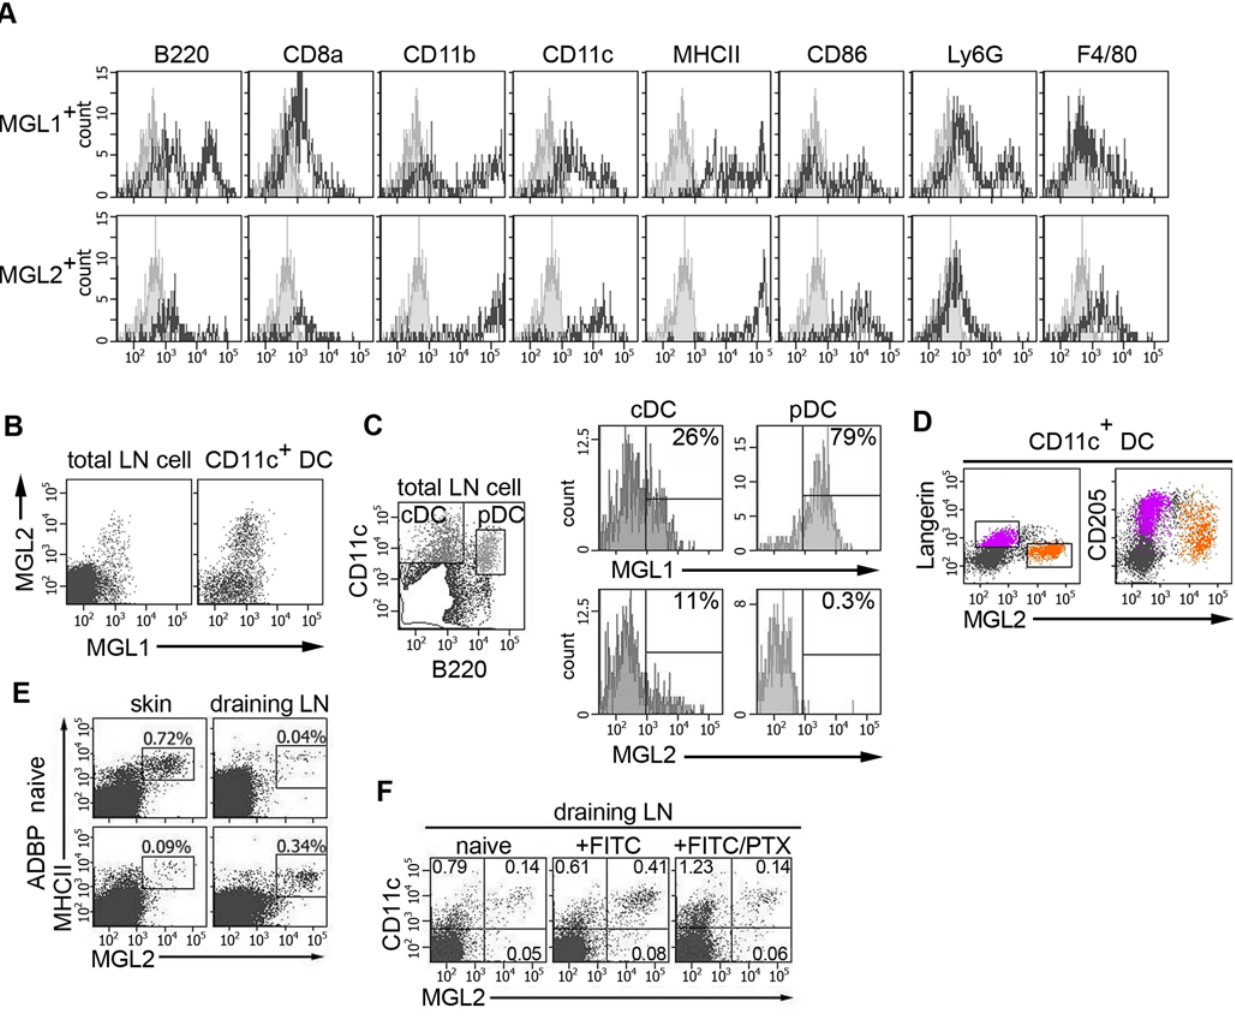
Figure 3. Surface phenotype of MGL1 + and MGL2 + cells in naive peripheral LNs revealed by the flow cytometric analysis. (A) Surface marker staining on cells gated on MGL1 + or MGL2 + populations in naive cutaneous LN. The gray peak in each panel indicates binding of rat IgG2a as a negative control. (B) Double staining of anit-MGL1 and anti-MGL2 mAbs on the total LN cells (left) or MACS-purified CD11c + DCs (right). (C) Surface staining by anti-MGL1 and anti-MGL2 mAbs on B220 + CD11c int pDCs and B220 2 CD11c + cDCs. Each DC subset was gated as in the left panel. (D) Intracellular staining of Langerin and surface staining of CD205 and MGL2 in MACS-purified CD11c + DCs. Langerin + and MGL2 + cells were shown in purple and orange respectively as gated in the left panel. (E) Flow cytometric analysis of the ratio of MGL2 + DC (gated) in the naive and ADBP-treated (24 h after the irritation) skins and LNs. Note that MGL2 signal was bright in all samples, suggesting that MGL2 expression was stable upon migration. (F) Effect of PTX on the ratio of MGL2 + DDC after FITC sensitization. The increase in the number of MGL2 + CD11c + DC induced by FITC ( + FITC) was significantly reduced ( p , 0.05) by concurrent administration of PTX with FITC painting ( + FITC/PTX).